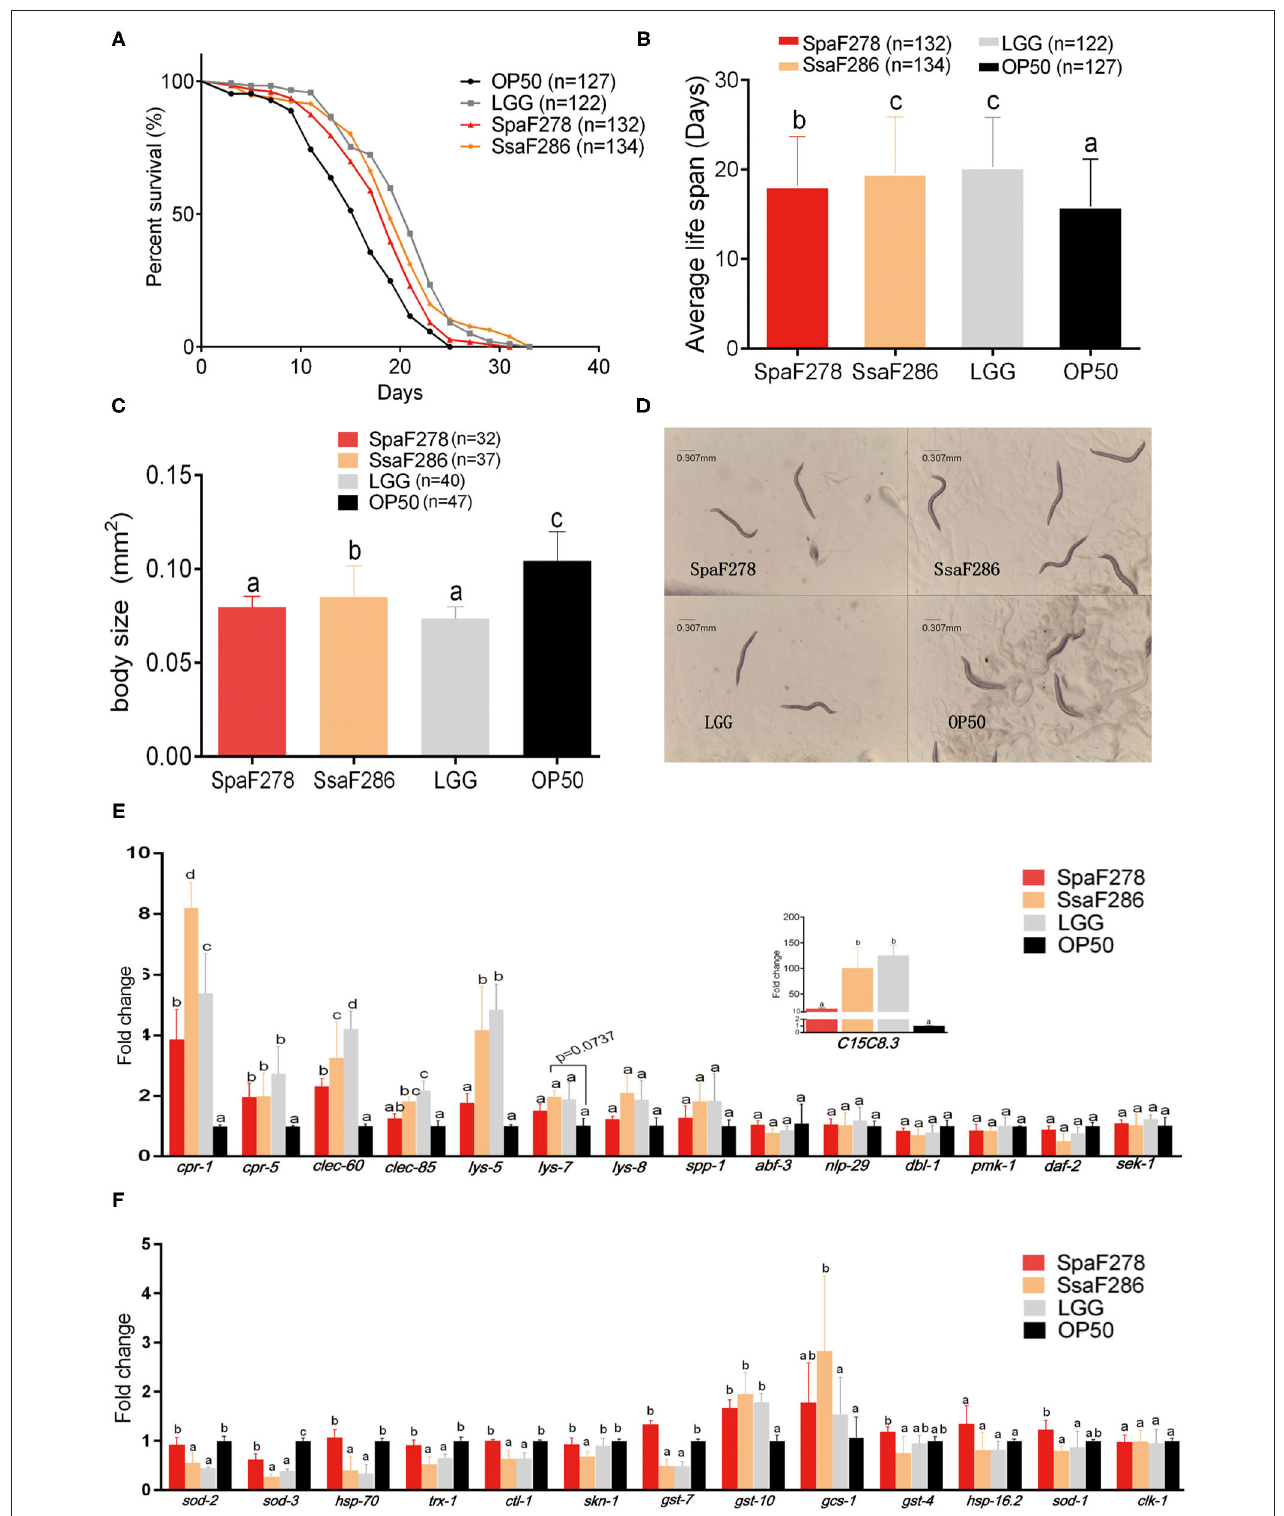
FIGURE 6 | Effects of S. salivarius F286, S. parasanguinis F278 and LGG cells on the lifespan, body size and expression of immune and antioxidant genes of C. elegans . (A,B) Survival curves (A) and average lifespan (B) of C. elegans fed E. coli OP50 (standard food), S. parasanguinis F278, S. salivarius F286, and LGG. Data are shown as the mean ± SD, and animal groups with different letters are significantly different by the log-rank test. (C,D) Body size (C) and microscopic images (D)